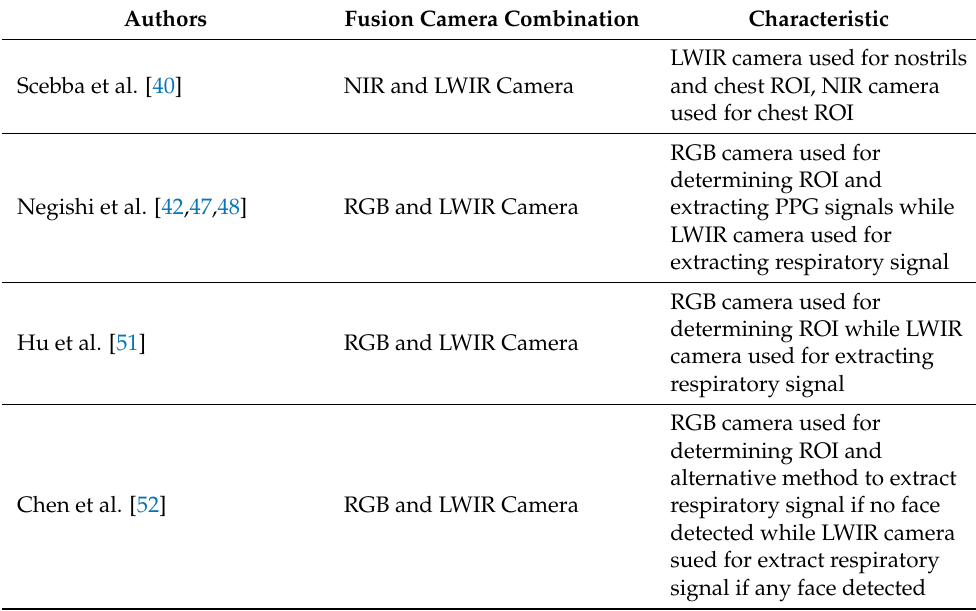
Table 4. List of Studies Involved Camera Fusion and Its